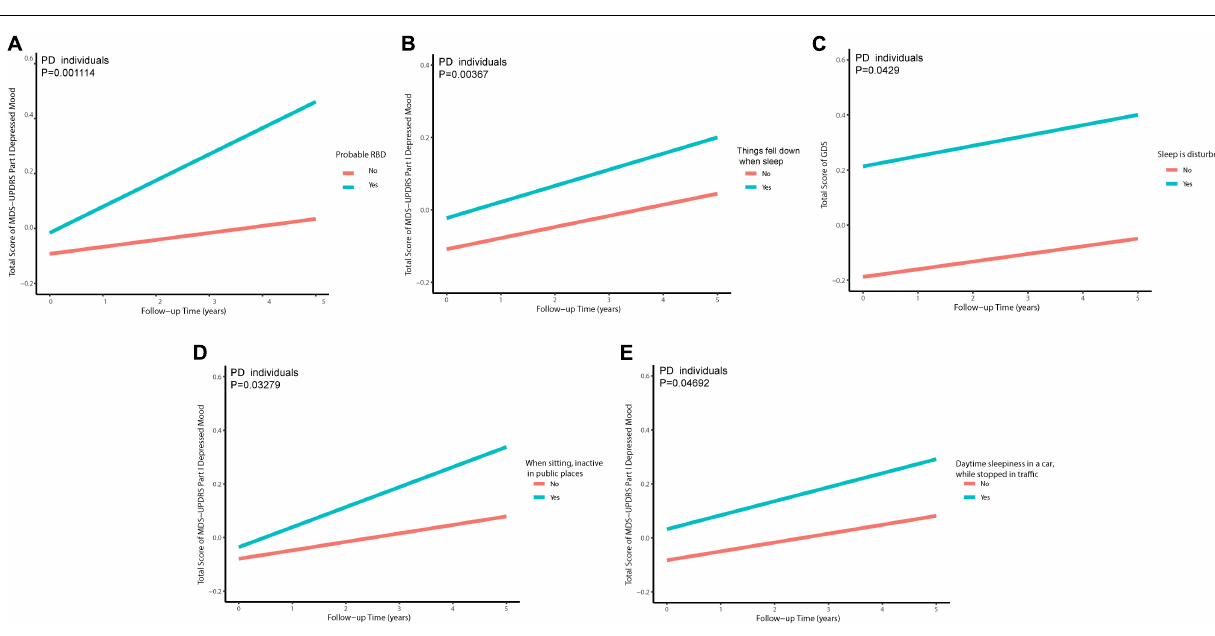
between RBD and GDS, and also urinary dysfunction as a part mediator ( Figure 6 and Supplementary Tables 11 , 12